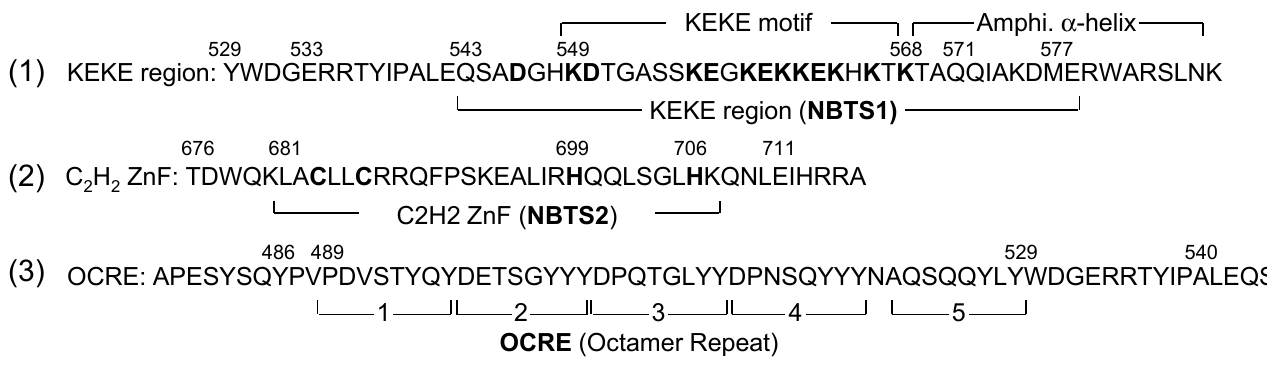
Figure 3. Primary sequences of the KEKE, C 2 H 2 ZnF, and OCRE regions. ( 1 ) KEKE region. Alternating positive and negative aa in the KEKE region are indicated in boldface. “Amphi. α -helix” is a region predicted to form a perfect amphipathic α -helix (AAH) with five helical turns [1]. ( 2 ) C 2 H 2 ZnF. Cysteine and histidine residues critical for ZnF function are highlighted in boldface. ( 3 ) OCRE (octamer repeat, alias NLS3). Brackets 1–5 represent five repeating octamers (8 aa) originally assigned based on hydrophilicity/hydrophobicity profiles [1]. The aa 486–540 region (aa 564–618 of the 930-aa isoform) forms a globular domain with an anti-parallel β -sheet fold